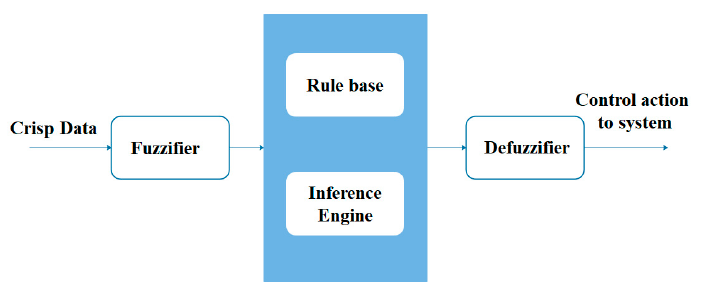
Figure 13. Basic block set for fuzzy logic controller (FLC).